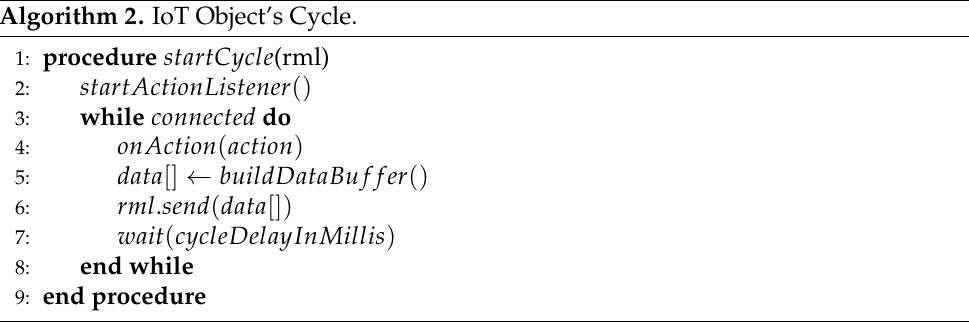
Algorithm 2. IoT Object’s